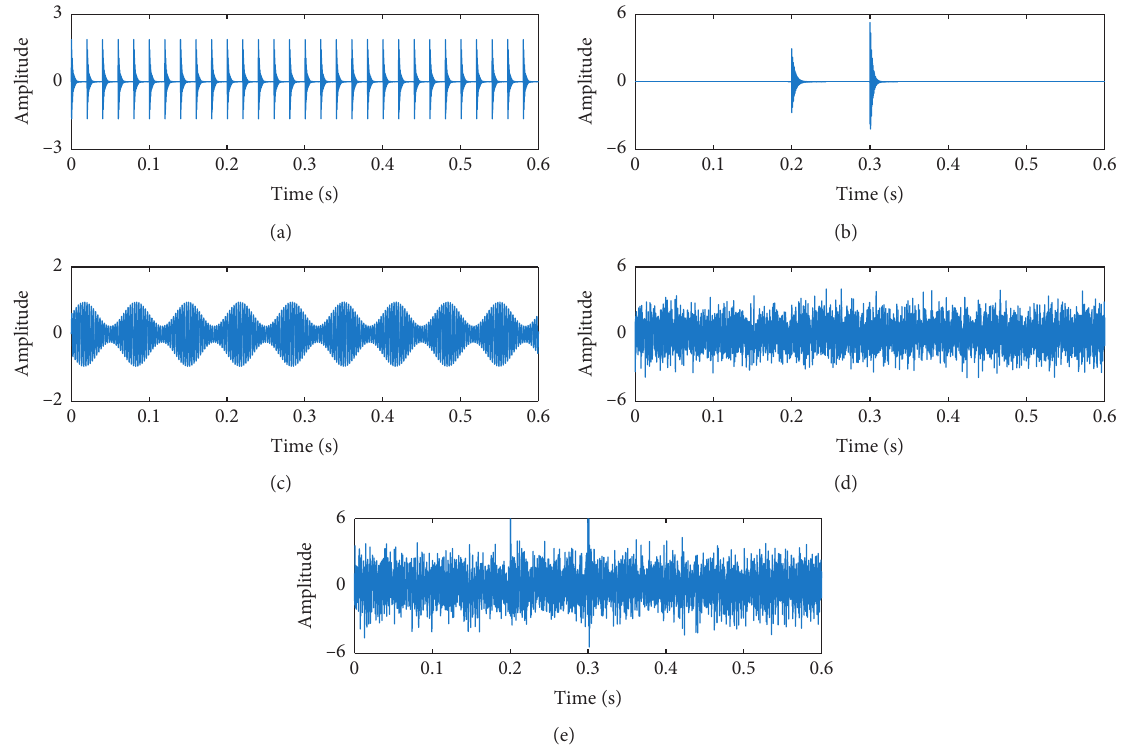
Figure 4: Time-domain waveform of simulated signals. (a) Periodic impulse components ( y ) , (c) modulation harmonic components ( y components ( y 2 ( Y ) .